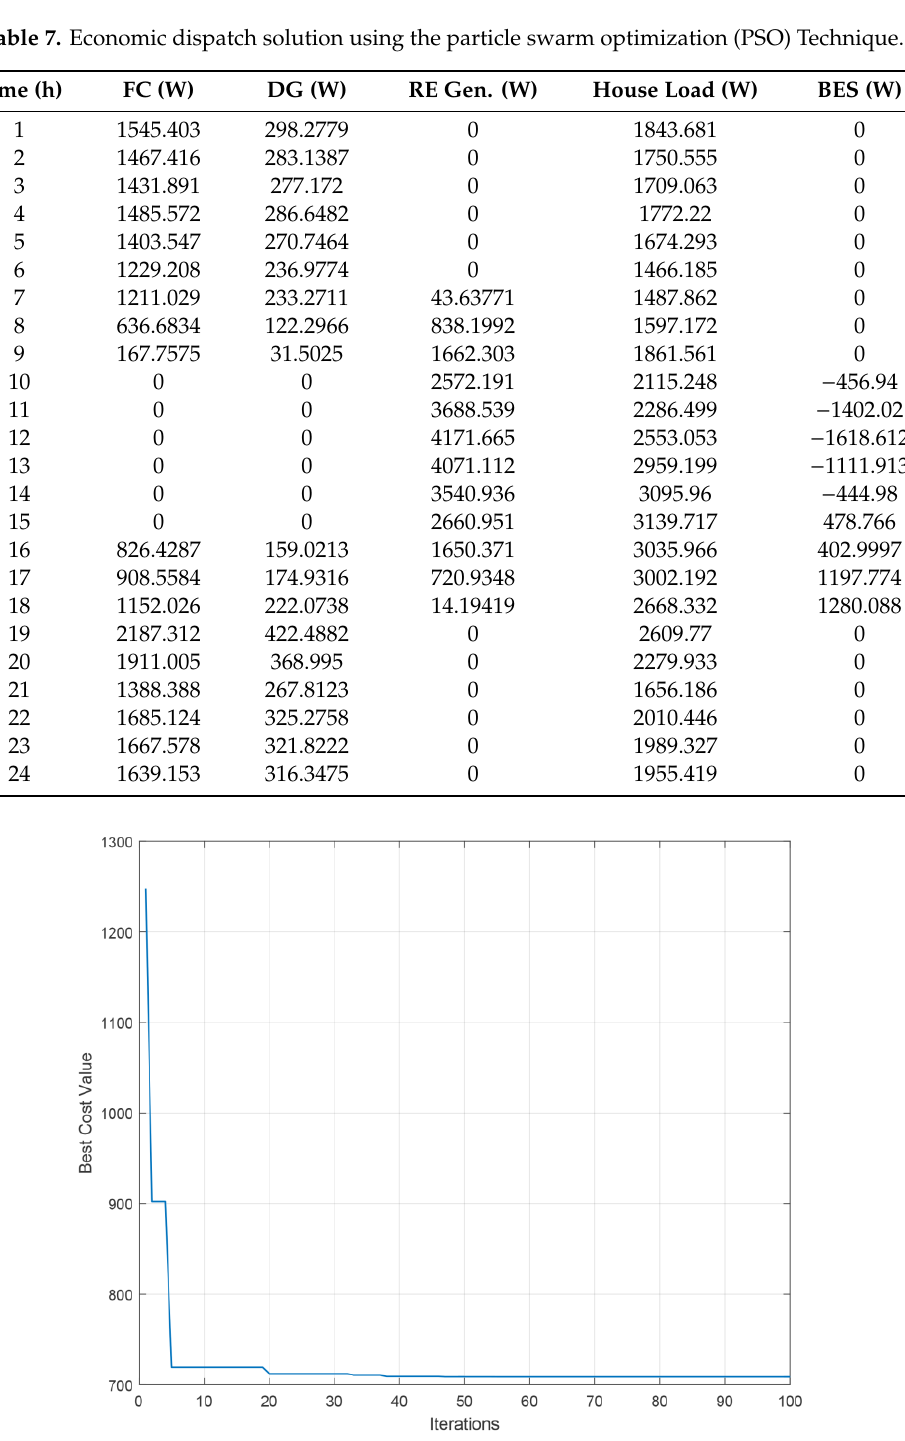
Figure 18. Convergence of best value of the cost function using particle swarm optimization (PSO).